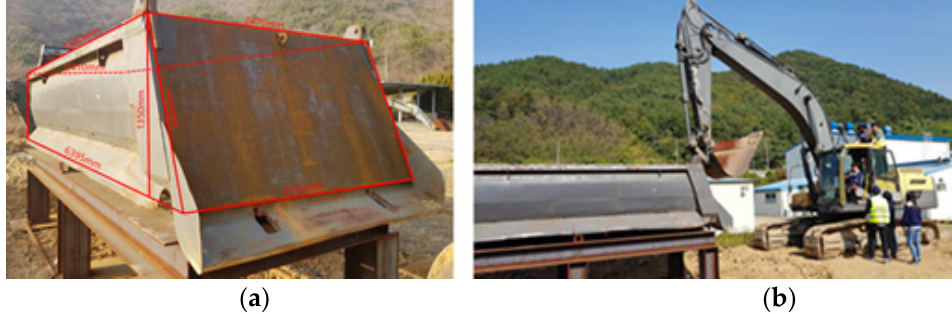
Figure 18. Three-dimensional location estimation experiment for the cargo box of dump truck: ( a ) an experimental model built for experimentation; ( b ) an experiment example using an excavator. The sensor is placed on the top of the